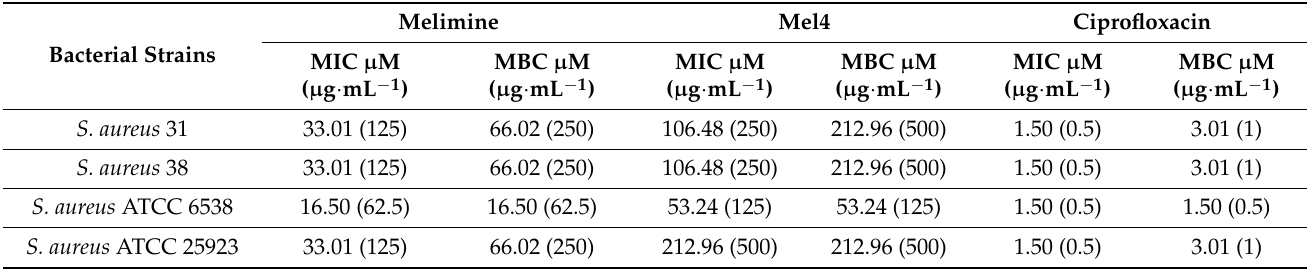
Table 1. MIC and MBC values of melimine, Mel4 and ciprofloxacin against S. aureus .